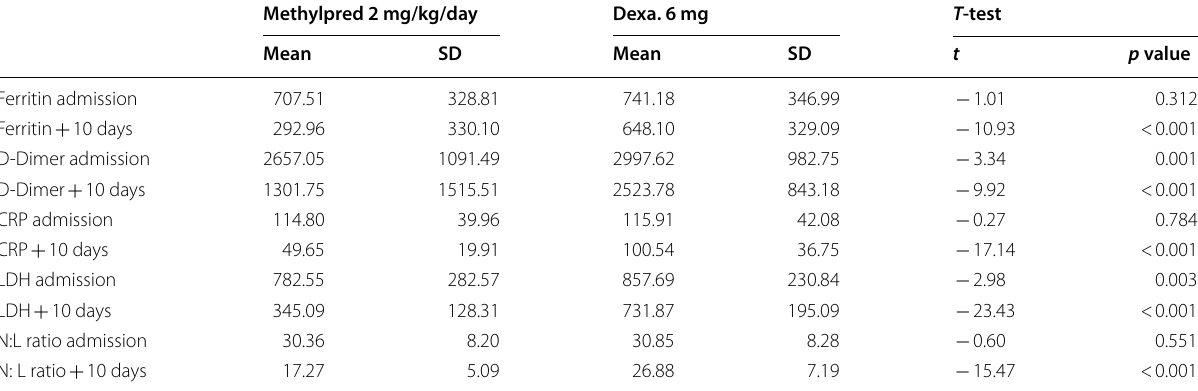
Table 2 Comparison of cytokine storm markers on admission and on the 10th day of treatment